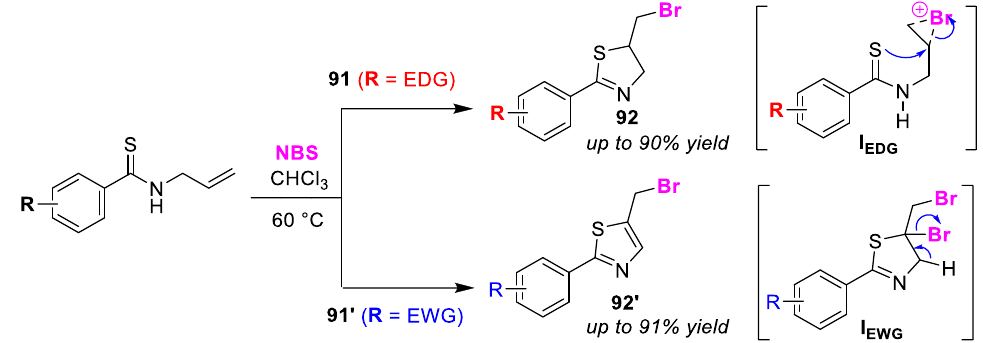
Figure 43. Selective syntheses of thiazolines 92 and thiazoles 9 2′ via bromocyclizations of functionalized N -allylbenzenethioamides ( 91 and 9 1′ ) using NBS.